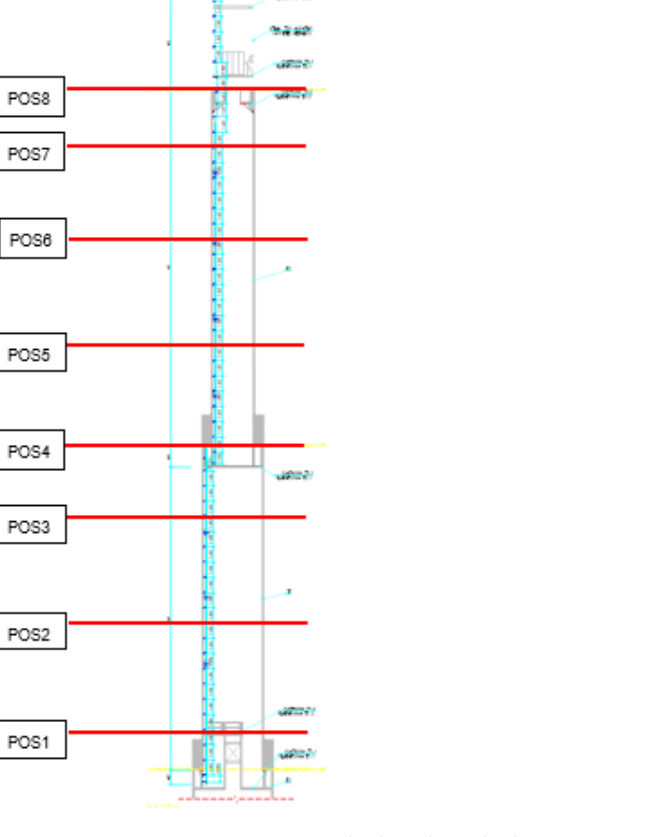
Figure 20. Communications system deployed inside the ELICAN